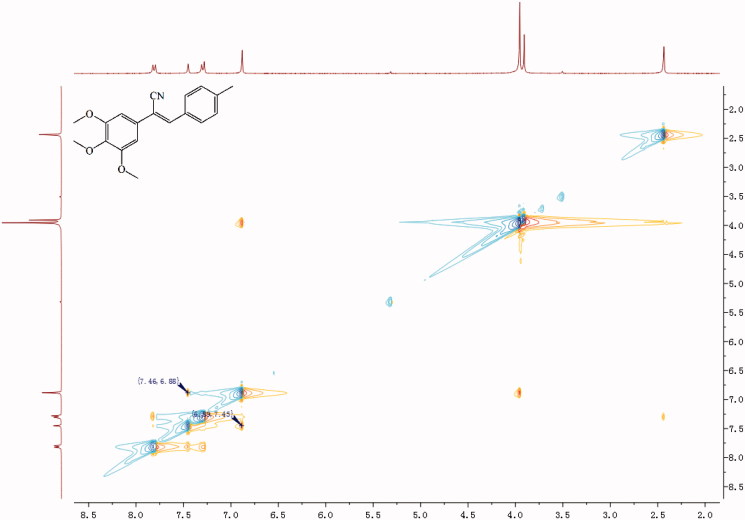
NOE (nuclear overhauser effect) result of compound 6h.